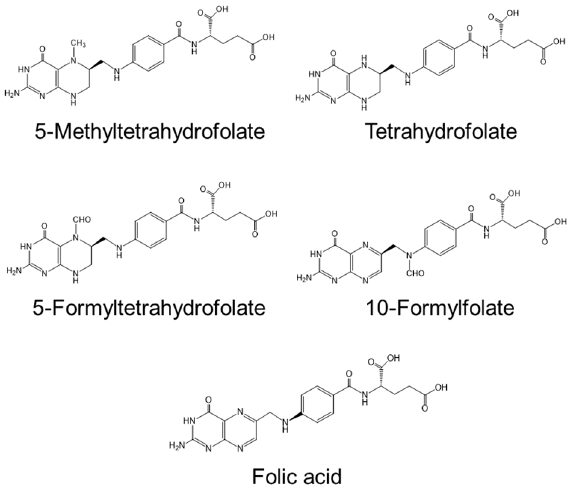
Figure 3. Chemical structures of folate compounds found in commercially available Chlorella products.